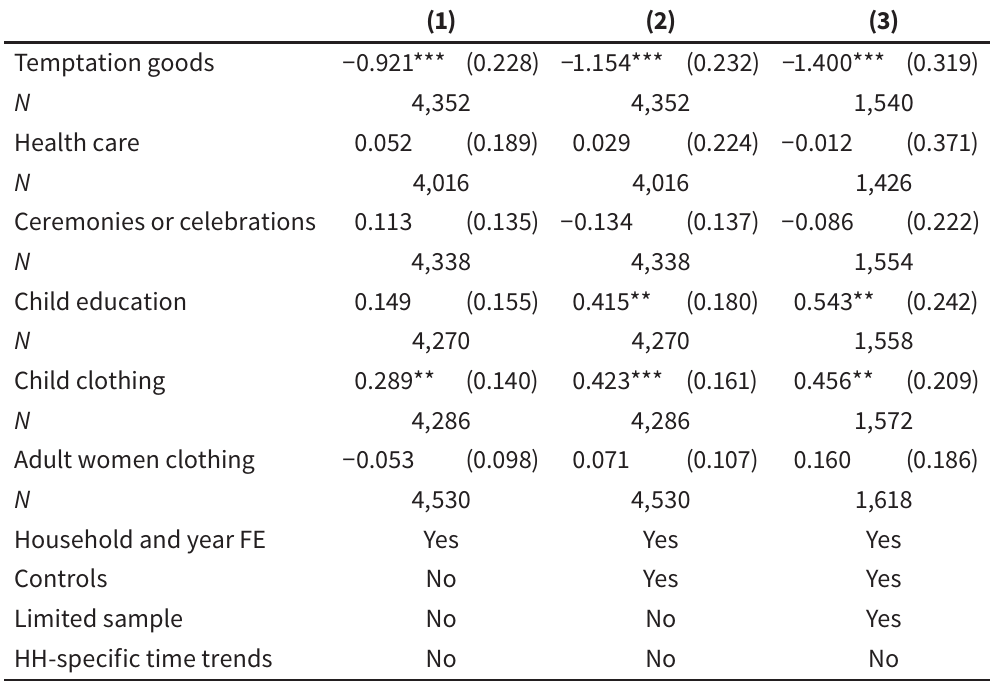
Shifts in expenditures ( asinh ) as the husband’s migrant status changes – only considering the first two rounds of data (1) (2)